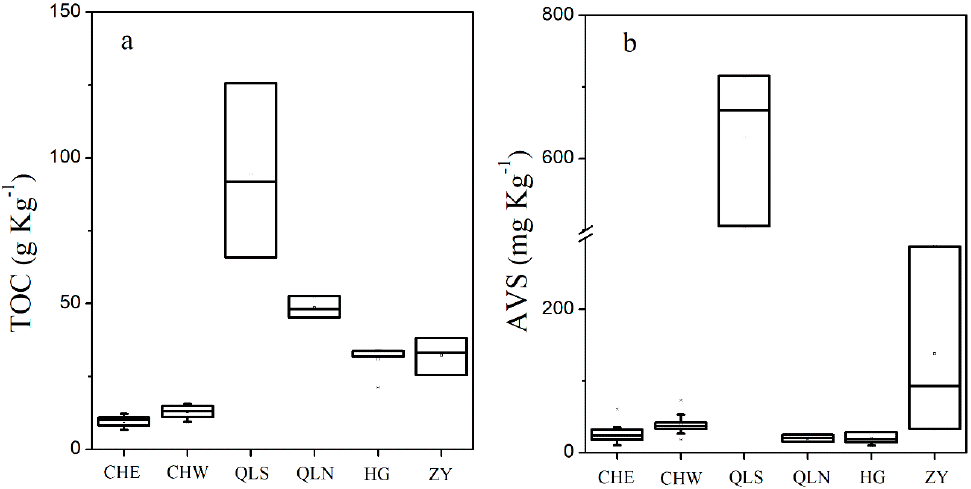
Figure 3. Boxplots showed the mean contents of total organic carbon (TOC) ( a ) and acid volatile sulfide (AVS) ( b ) in sediments of the east (CHE) and west basins (CHW) of Lake Chaohu, south (QLS) and north (QLN) basins of Lake Qingling, Lake Houguan (HG), and Lake Zhiyin (ZY). Horizontal lines indicate the median, small squares show the mean, asterisks indicate the outliers, the boxes give the 25th and 75th percentiles, and bars show the range from the 5th to 95th percentiles.